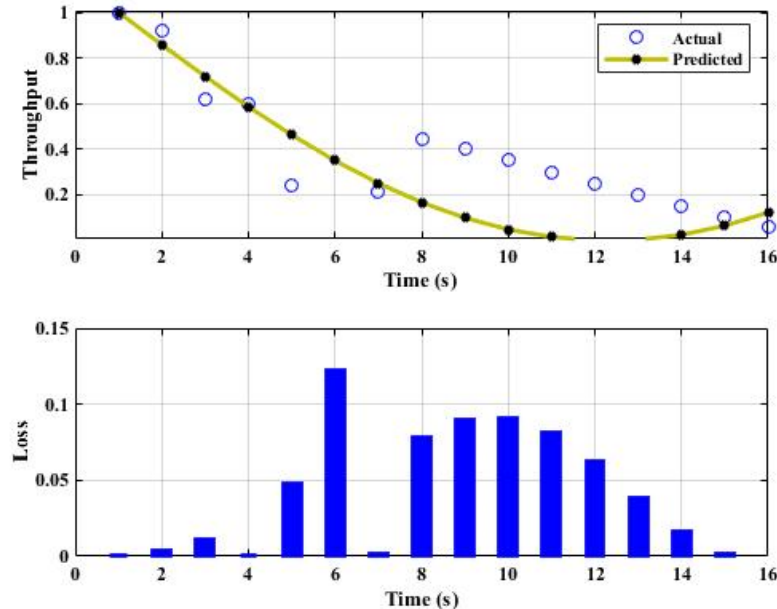
Figure 7. The predicted output at a transmission rate of 12 packets/s.